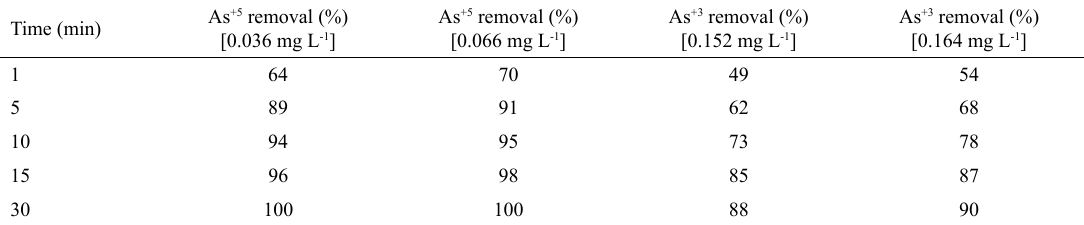
Table 2: Results of the removal of As ions (As +3 y As +5 ) from water. The initial concentration of As in the solution is indicated in square brackets. Time